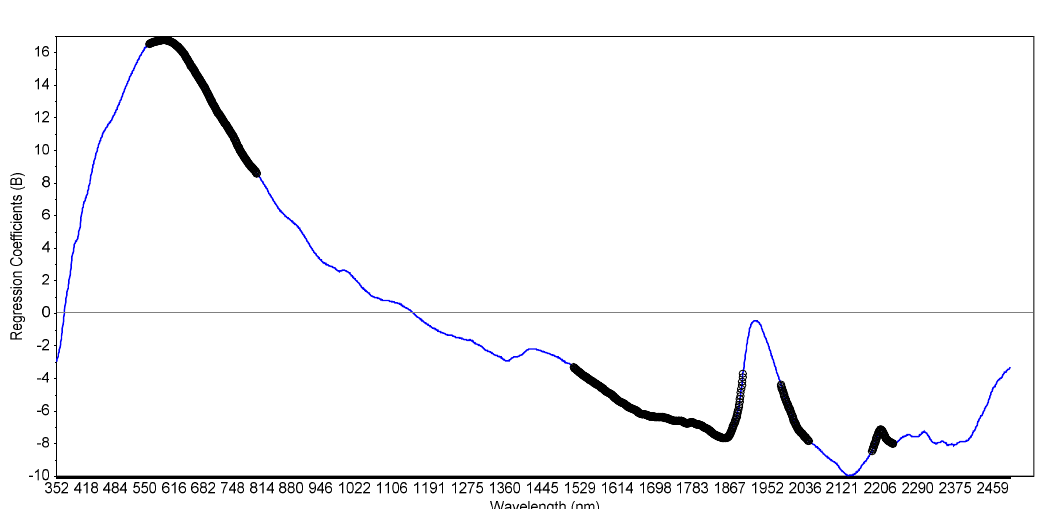
Figure 6. Plot of regression coefficients obtained from PLS regression of sum 16PAH. The thick black line represents the important variables regions (wavelengths) for prediction.